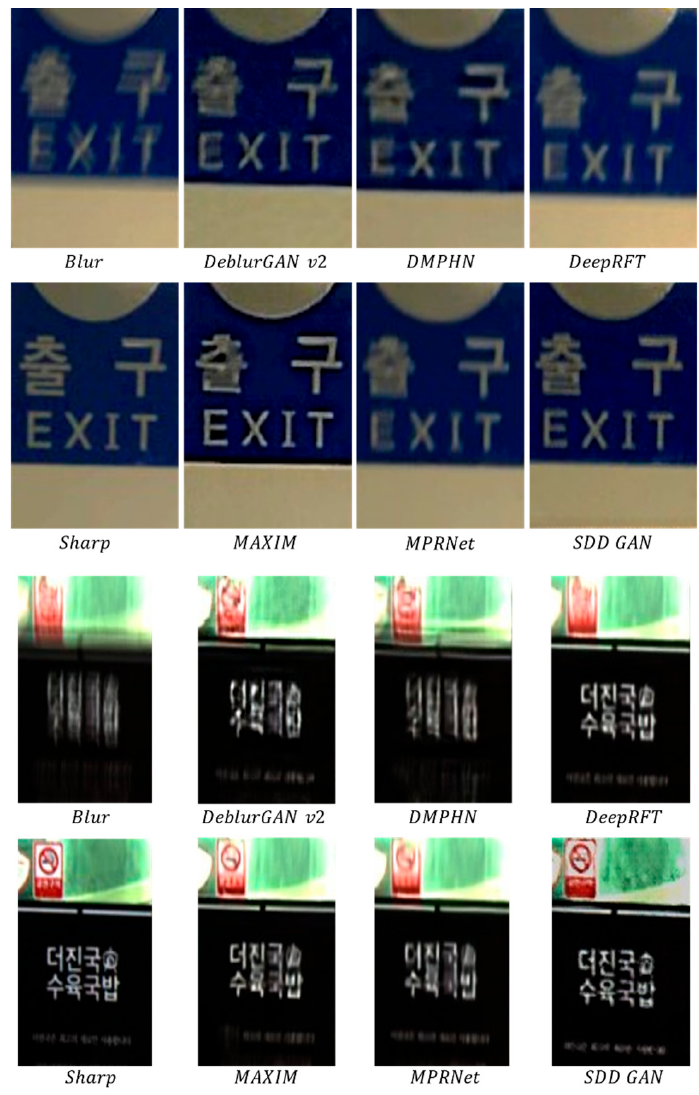
Figure 9. Comparison of recovery results for the RealBlur-R dataset. Real satellite images: The results of Restormer [47], DeblurGAN-v2 [11], DBGAN [40], and MAXIM [20] on real satellite remote sensing data were qualitatively analyzed.